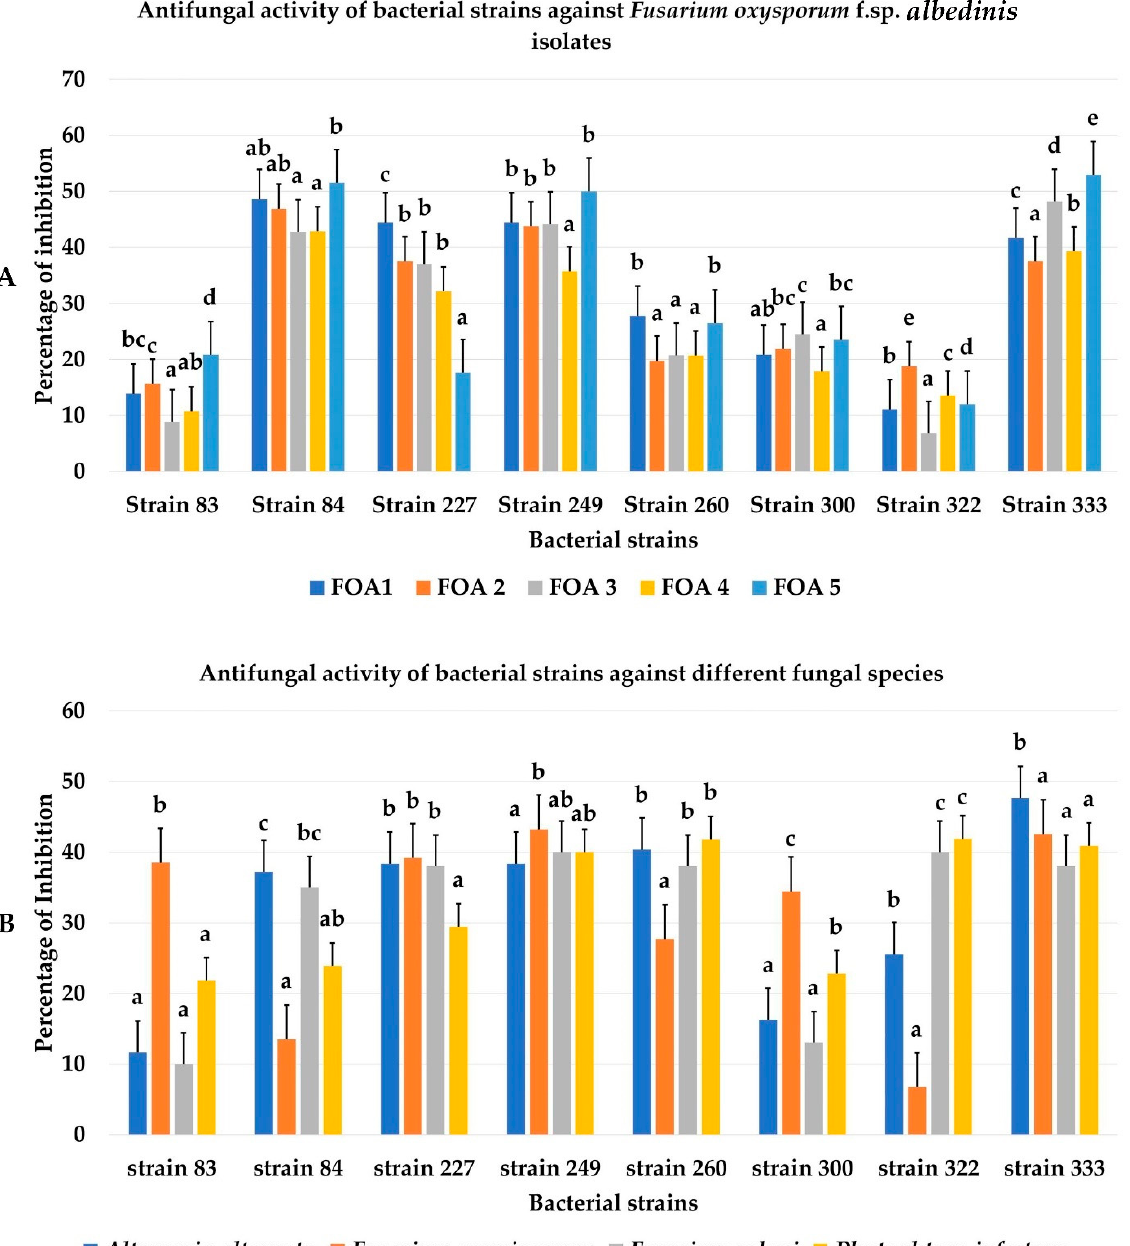
Figure 3. ( A ) Percentage of inhibition of selected bacterial strains (83, 84, 227, 249, 260, 300, 322, and 333) against different strains of FOA (FOA1, FOA2, FOA3, FOA4, and FOA5). ( B ) Inhibition rate of bacterial strains against other plant pathogens (Alternaria alternata, Fusarium graminearum, Fusarium solani, and Phytophthora infestans). The data present the means ± the standard error. Different letters between bars in each group indicate a significant difference at ( p < 0.05) determined by ANOVA with the comparison of means using Tukey’s HSD.